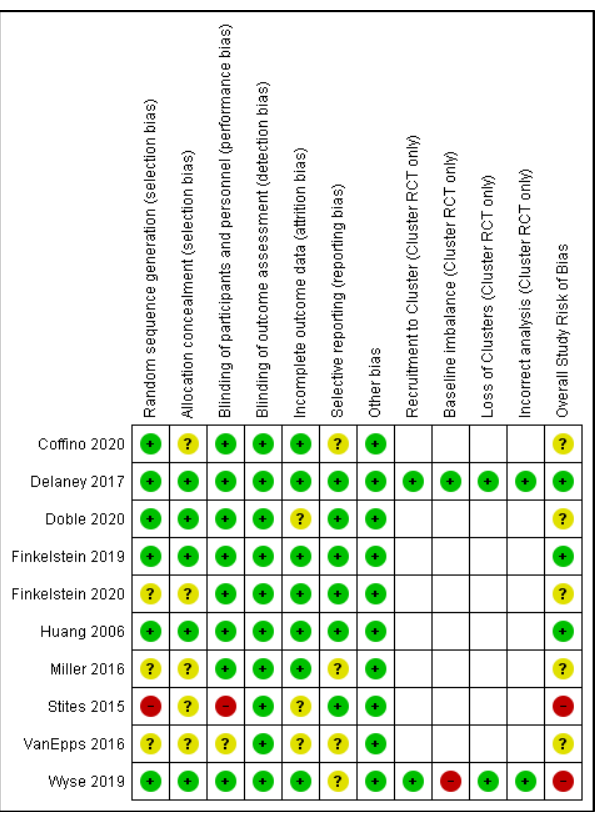
Figure 2. Risk of bias graph: review authors’ judgements about each risk of bias item for each included RCT and cluster-RCT. Green symbol represents low RoB; Yellow symbol represents unclear RoB; Red symbol represents high RoB.